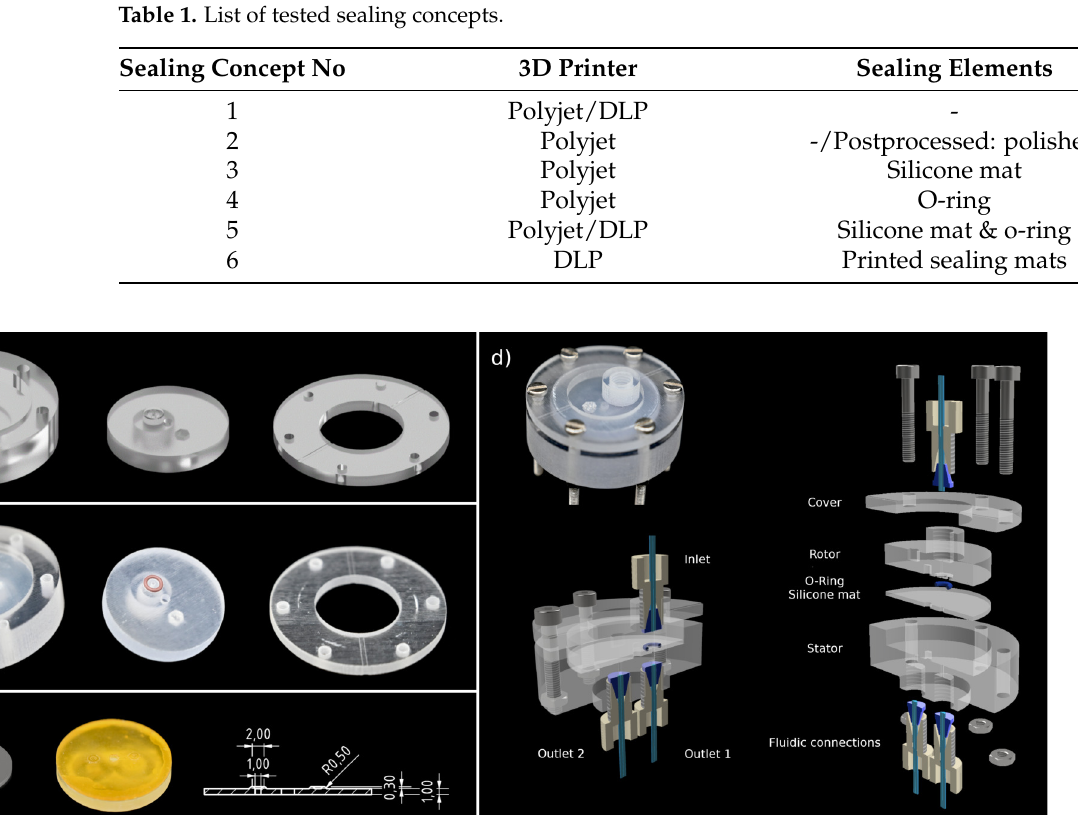
Figure 3. Design and implementation of test valve: ( a ) CAD drawing of stator, rotor, and cover; ( b ) 3D-printed rotor, stator, and cover: sealing area of the rotor is covered with a silicone mat, and an o-ring is placed in respective groove in rotor. Parts were printed with polyjetting; ( c ) from left to right: CAD drawing of 3D-printed sealing mat with integrated o-ring-like structures, 3D-printed sealing mat, technical drawing of the sealing mat; ( d ) top-left: assembled 3D-printed test valve; bottom-left and -right: section and exploded view of a CAD drawing of sealing concept 5 showing placement of respective sealing